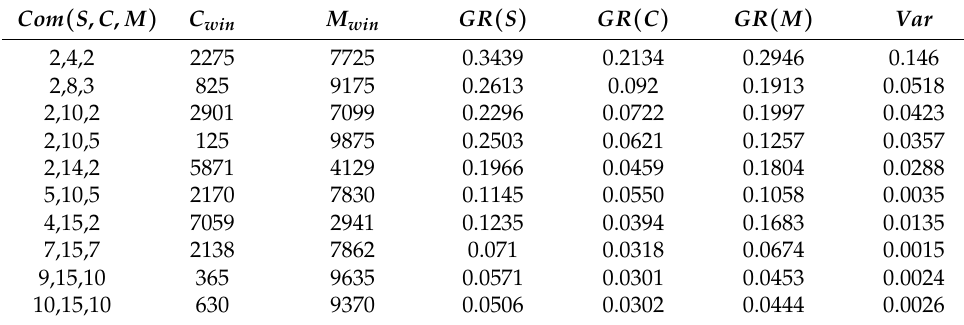
Table 2. GR measure of Mafia characters based on various